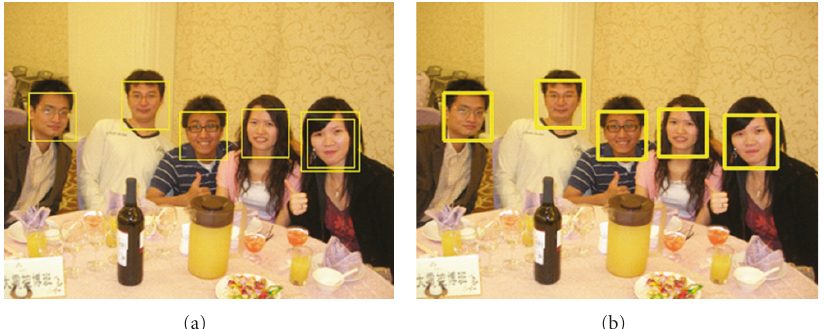
Figure 10: The results in the region based clustering, (a) for the local-scale clustering process and (b) for the global-scale clustering